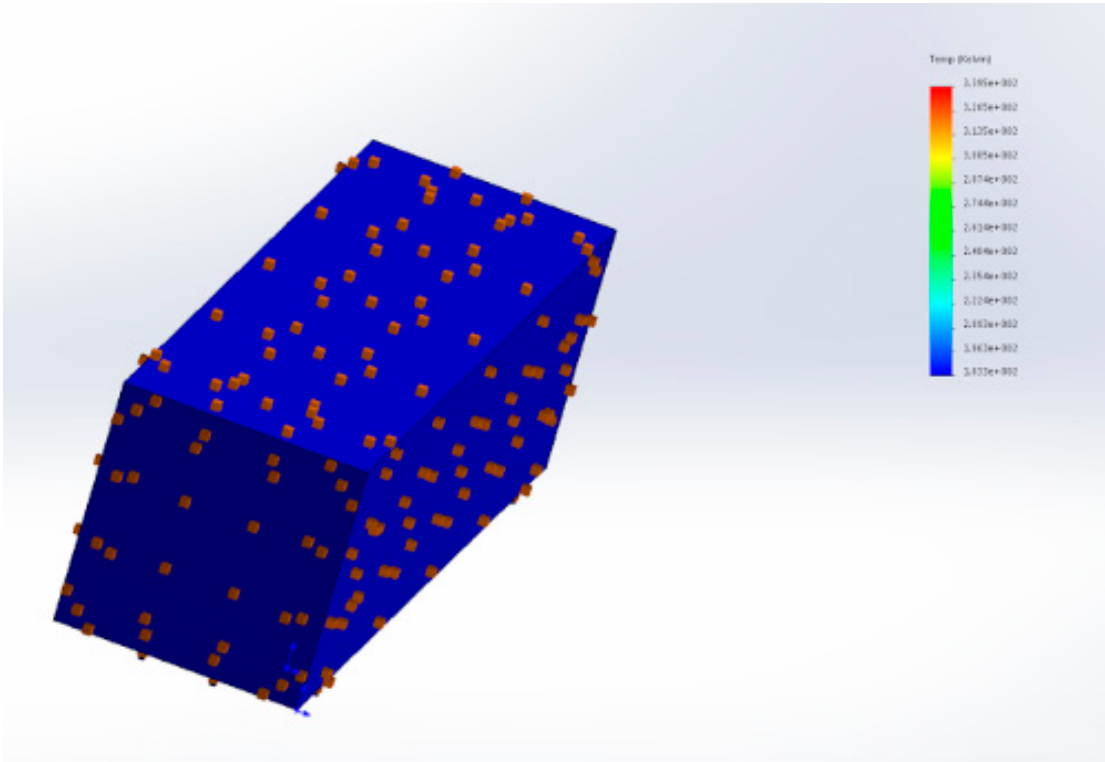
Figure 57. Steady-state Cold Case Testing Results.